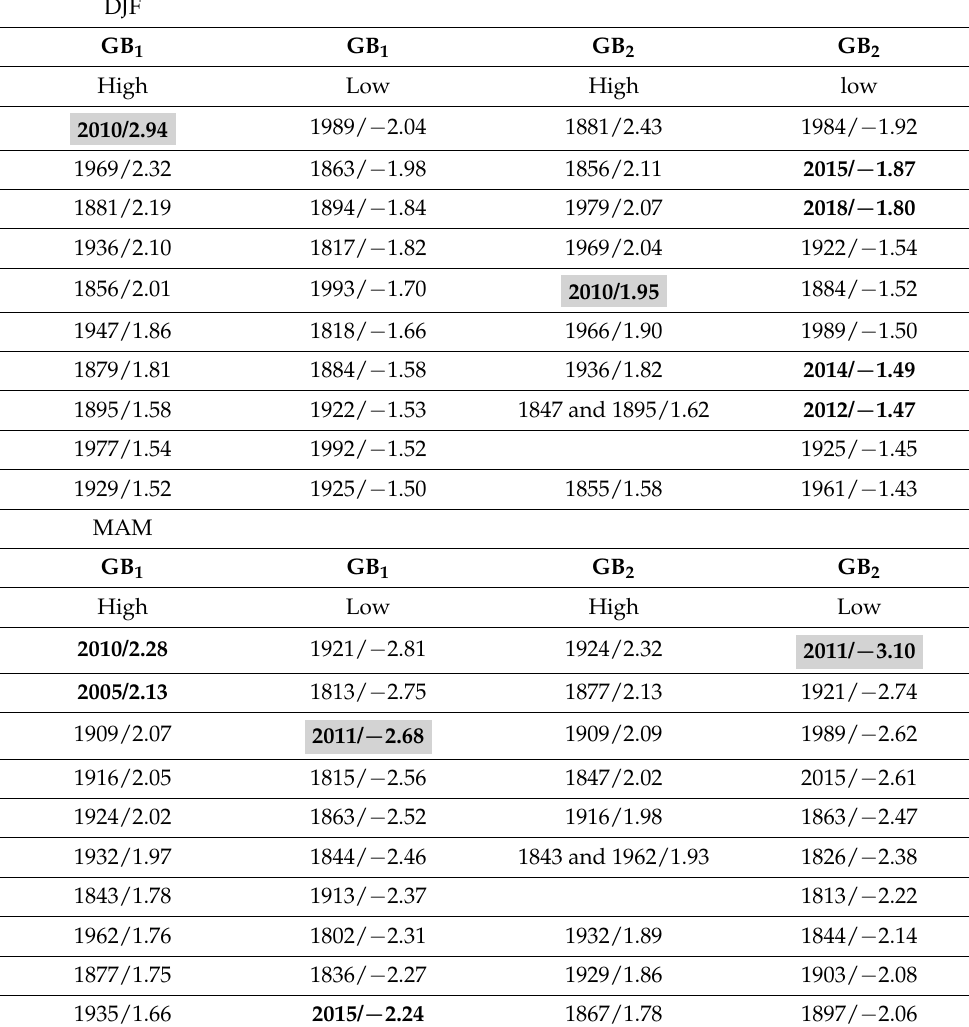
Table 3. Ten highest and ten lowest GB 1 and GB 2 years/values for each season for 1800–2020. Years since 2000 inclusive are emboldened, and these years are also shaded where they feature in both GB